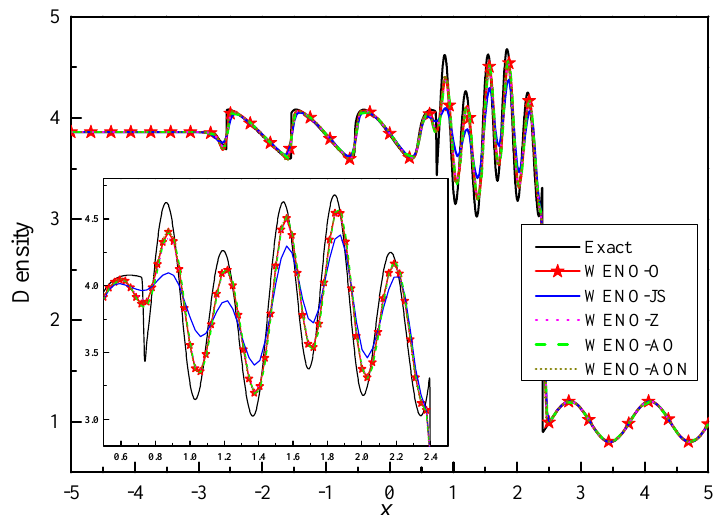
Figure 18. Numerical results of Shu–Osher problem of Example 6 (Section 6.2.3) for density field at time t = 1.8, CFL = 0.1 with 320 cells for considered WENO